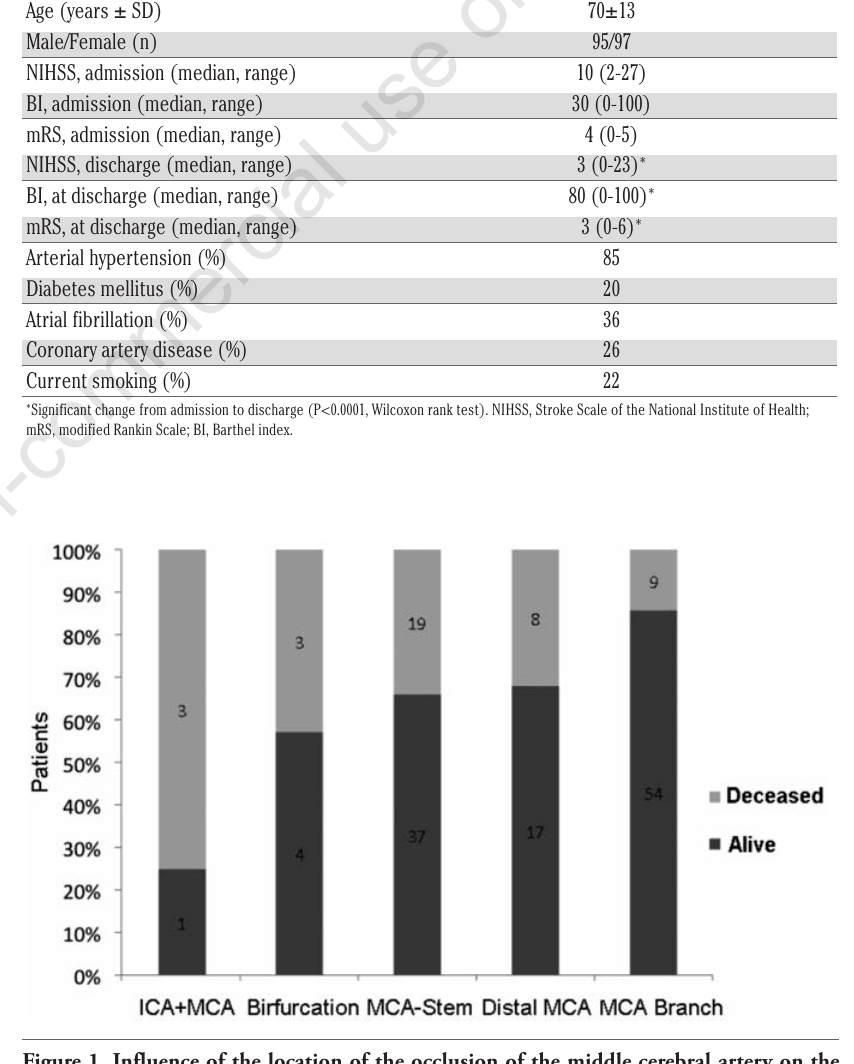
Figure 1. Influence of the location of the occlusion of the middle cerebral artery on the rate of survival. The numbers in each column indicate the number of